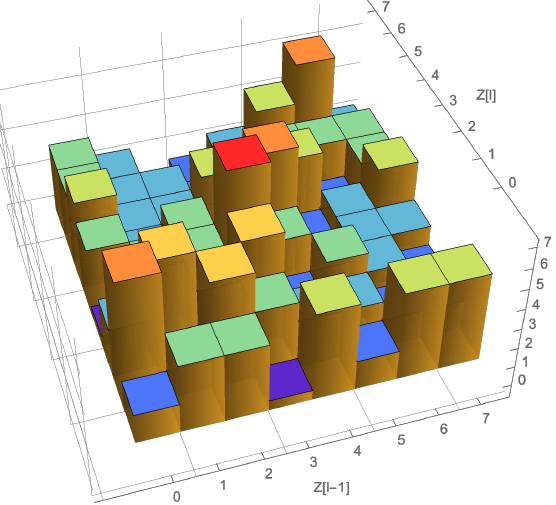
Figure 8. Expected two-dimensional transitional frequency data of toy example outputs, shown through a surface plot histogram.